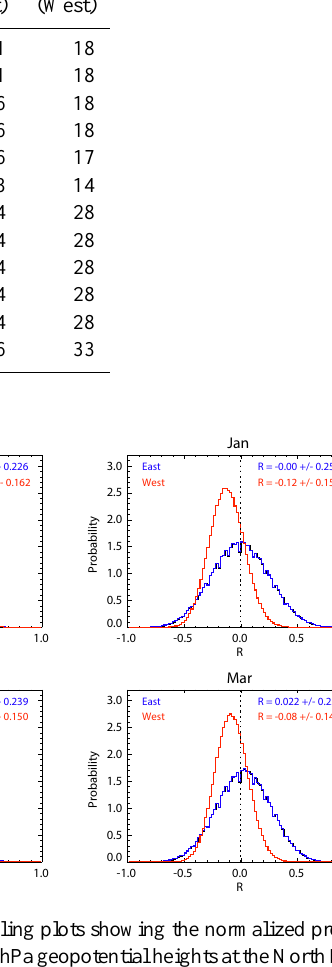
Table 2. Variation in the Spearman rank correlation between the 30hPa geopotential heights in February at 90 ◦ N and the 255nm spec- tral irradiance for the QBO east and west phases. Results are for this study (WACCM4a, WACCM4b), four CCMVal-2 simulations, and NCEP-NCAR Reanalysis with stratospheric wind observations (1953–2005 and 1953–2013) from Canton Island (3 ◦ S, 172 ◦ W), Gan Is- indicate the two-sided significance level of the correlations. Bold denotes the correlations with significance values above 90%. Model/ Period QBO QBO Obs.